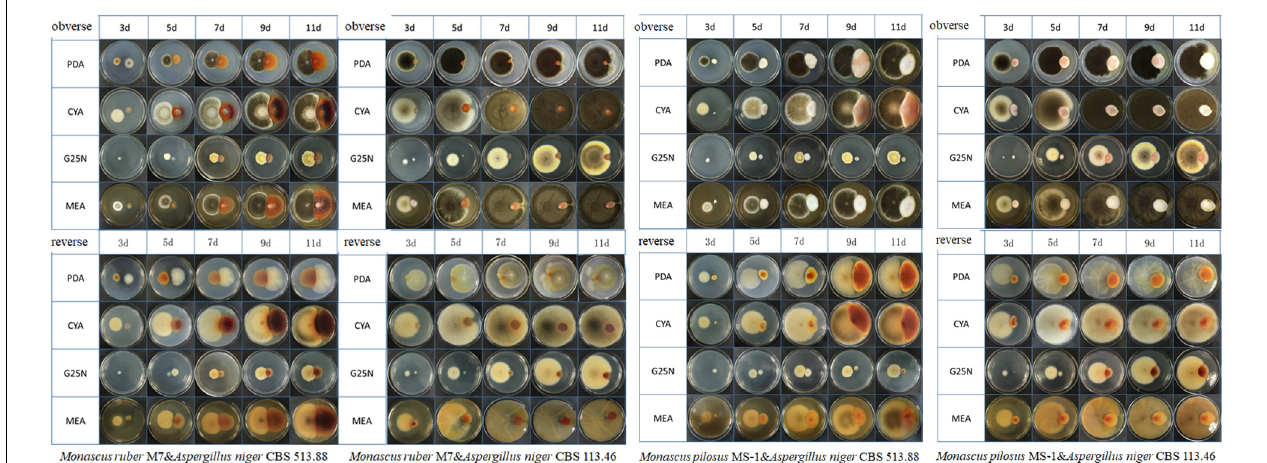
FIGURE 4 | Colonial morphologies of Monascus ruber M7, Monascus pilosus MS-1 when co-cultured with Aspergillus niger CBS 513.88 and A. niger CBS 113.46 by conventional (direct) cocultivation at 3, 5,7,9, and 11 days &-co-cultured